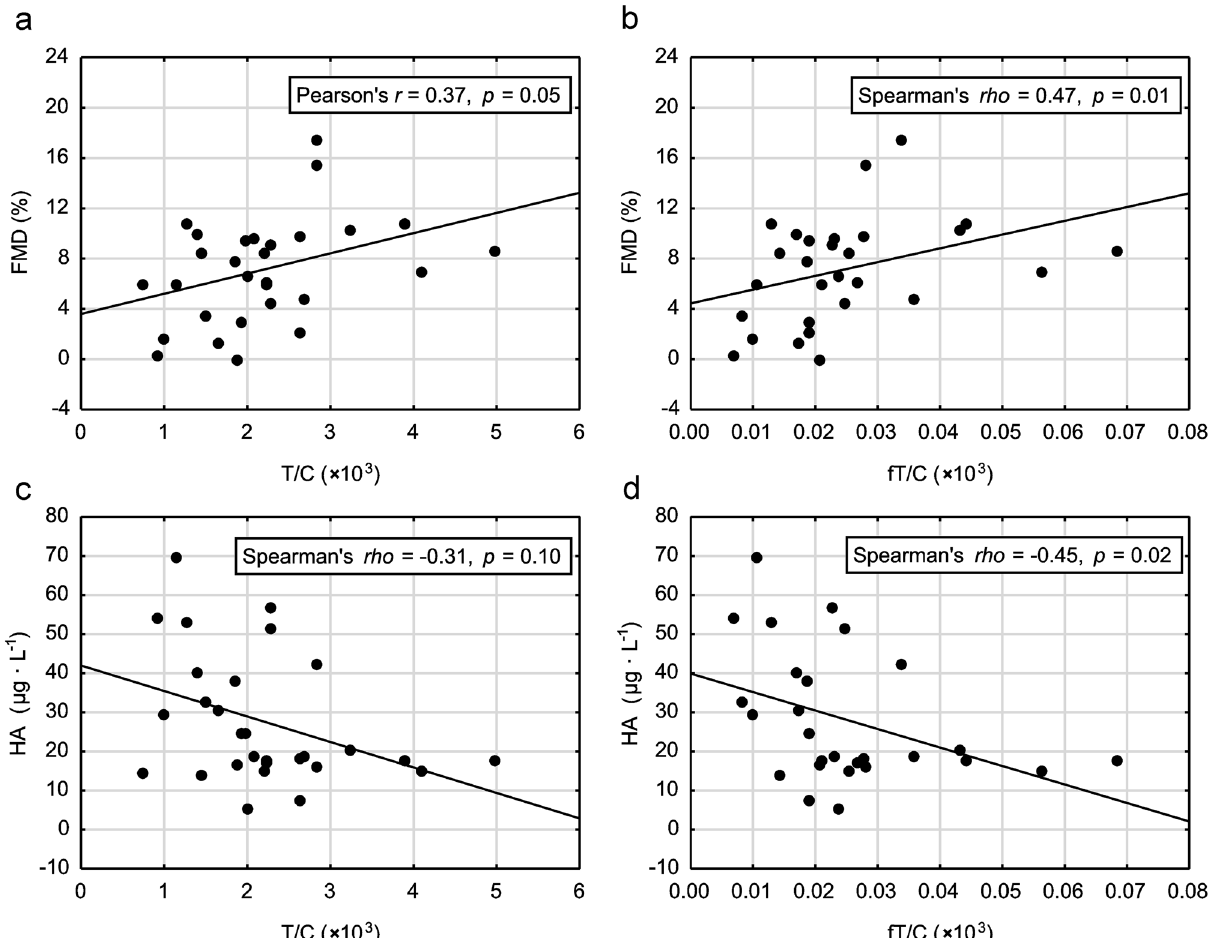
Figure 3. Correlations between androgen status (testosterone to cortisol ratio—T/C and free testosterone to cortisol ratio—fT/C) and flow-mediated dilation (FMD), panel ( a , b ) and between androgen status (T/C and fT/C) and hyaluronic acid (HA), panel ( c , d ), in all studied women (n =